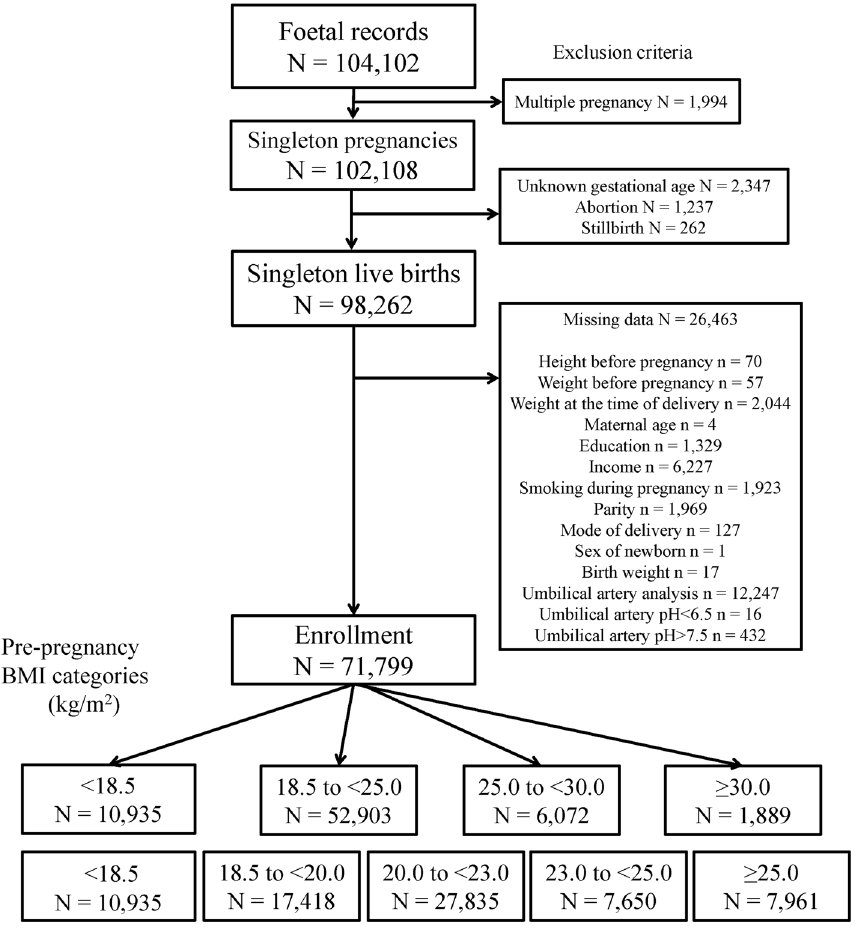
Figure 1. Flowchart of study